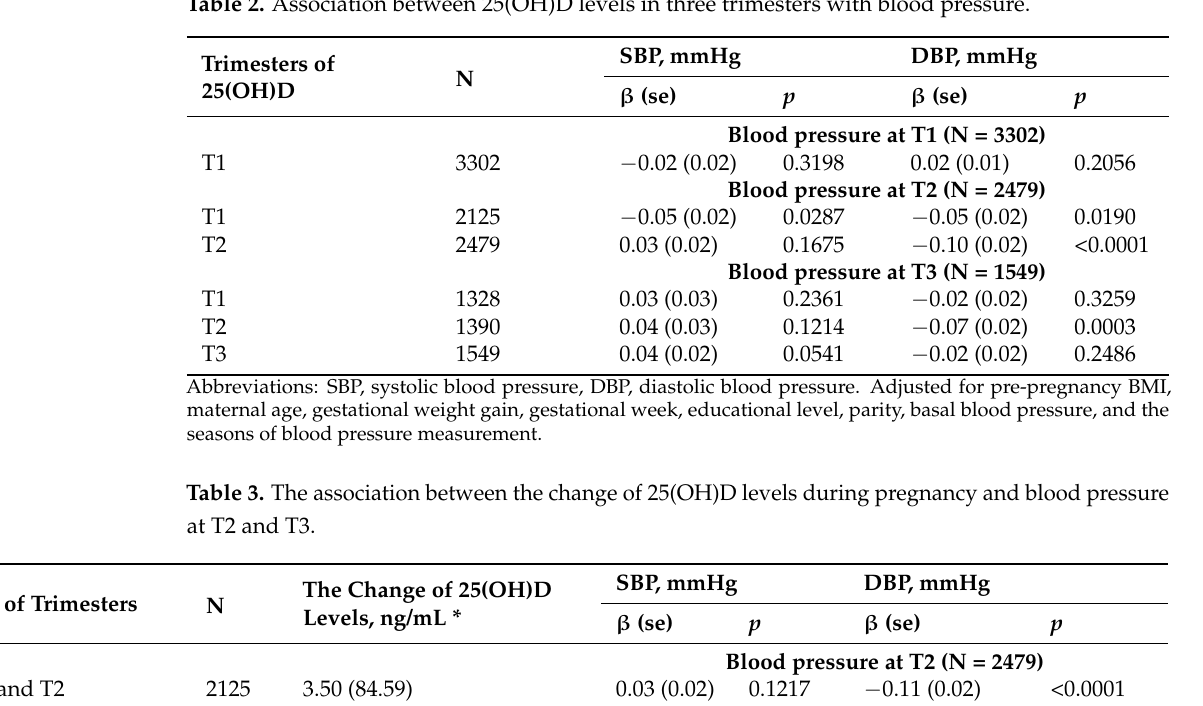
T2 and T3, respectively ( β (se) = − 0.10 (0.02), p < 0.0001, β (se) = − 0.07 (0.02), p = 0.0003) (Table 2). The association between VitD deficiency in three trimesters with SBP and DBP were consistent with the above results (Table S2). For each 1 ng/mL increase in 25(OH)D changes between T1 and T2, DBP at T2 and T3 decreased by 0.11 (se = 0.02) mmHg and 0.11 (se = 0.02) mmHg, respectively ( p < 0.0001). (Table 3). Three subgroups of participants with data of 25(OH)D levels in three trimesters were identified by latent mixture modeling. Compared with women whose 25(OH)D levels remained low from T1 to T3, women whose 25(OH)D levels gradually increased at T2 and T3 or whose 25(OH)D levels remained high during pregnancy had lower DBP at T3 ( β (se) = − 1.13 (0.46), p = 0.0137, β (se) = − 1.74 (0.74), p = 0.0195) (Table 4). However, there was no significant association between 25(OH)D levels, VitD deficiency in three trimesters, the change of 25(OH)D levels, or the VitD trajectory during pregnancy with HDP (Tables S3–S6). Table 2. Association between 25(OH)D levels in three trimesters with blood pressure.